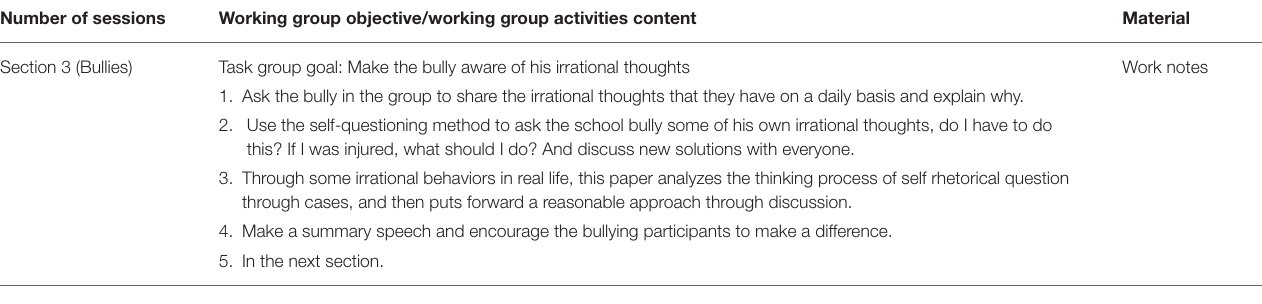
TABLE 6 | Emotional control and interpersonal skills. Number of